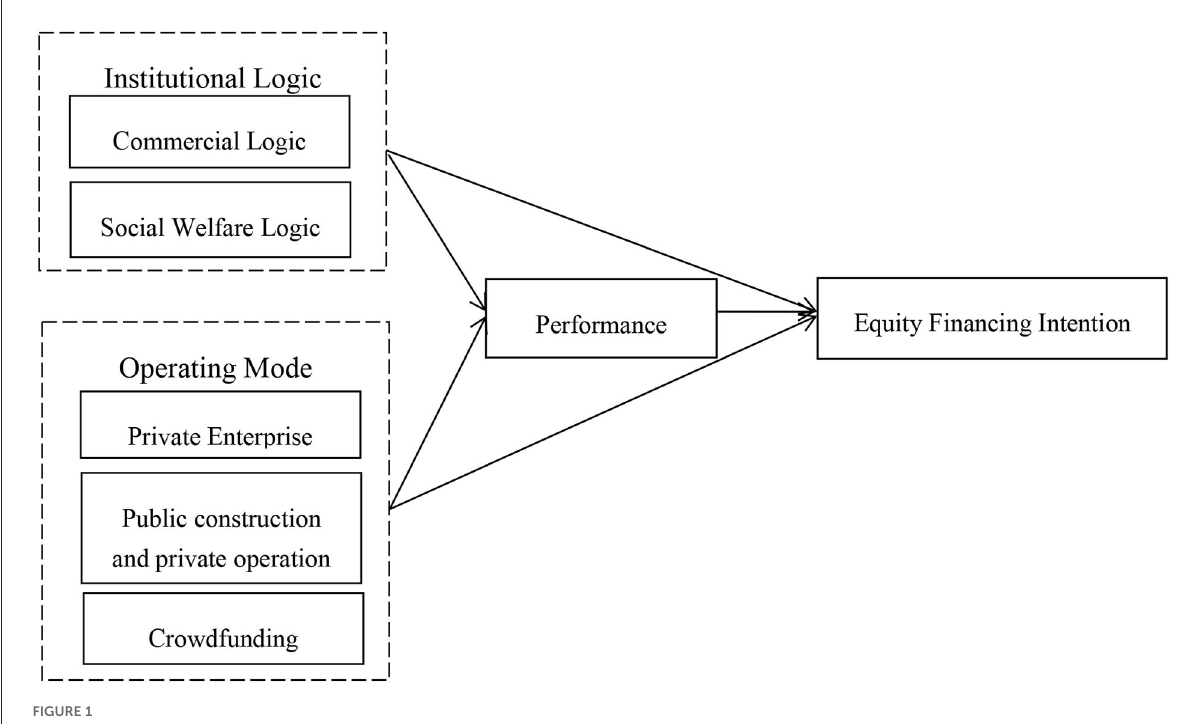
FIGURE1 Research